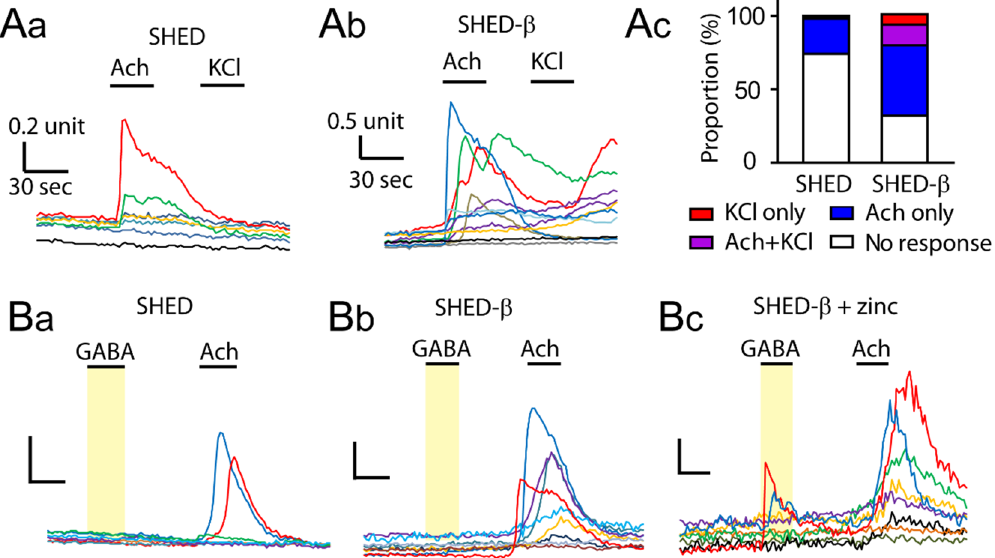
Figure 4. Changes in intracellular calcium levels in SHED β -cells in response to exogenous GABA challenge. Panel A: Excitation by Ach and KCl during di ff erentiation of SHED into SHED β -cells. Representative traces of ratiometric Ca 2 + imaging using Fura-2AM in undi ff erentiated SHED cells ( Aa ) and di ff erentiated SHED β -cells ( Ab ) at Day 10. Each trace represents time-dependent [Ca 2 + ] i changes in each cell. Ach (100 µ M) and KCl (50 mM) were superfused during the indicated time. Histogram ( Ac ) shows quantification of cells responding to KCl and / or Ach. Panel B: Supplementation of zinc during di ff erentiation a ff ects GABA-induced Ca 2 + responses in SHED β -cells. Examples of traces of Ca 2 + imaging in SHED cells ( Ba ), di ff erentiated SHED β -cells (Bb), and di ff erentiated SHED β -cells with zinc supplementation ( Bc ). GABA (100 µ M) and Ach (100 µ M) were superfused during the indicated time. Vertical scale bars represent 0.5 Fura units ( ∆ 340 / 380), and horizontal scale bars represent 30